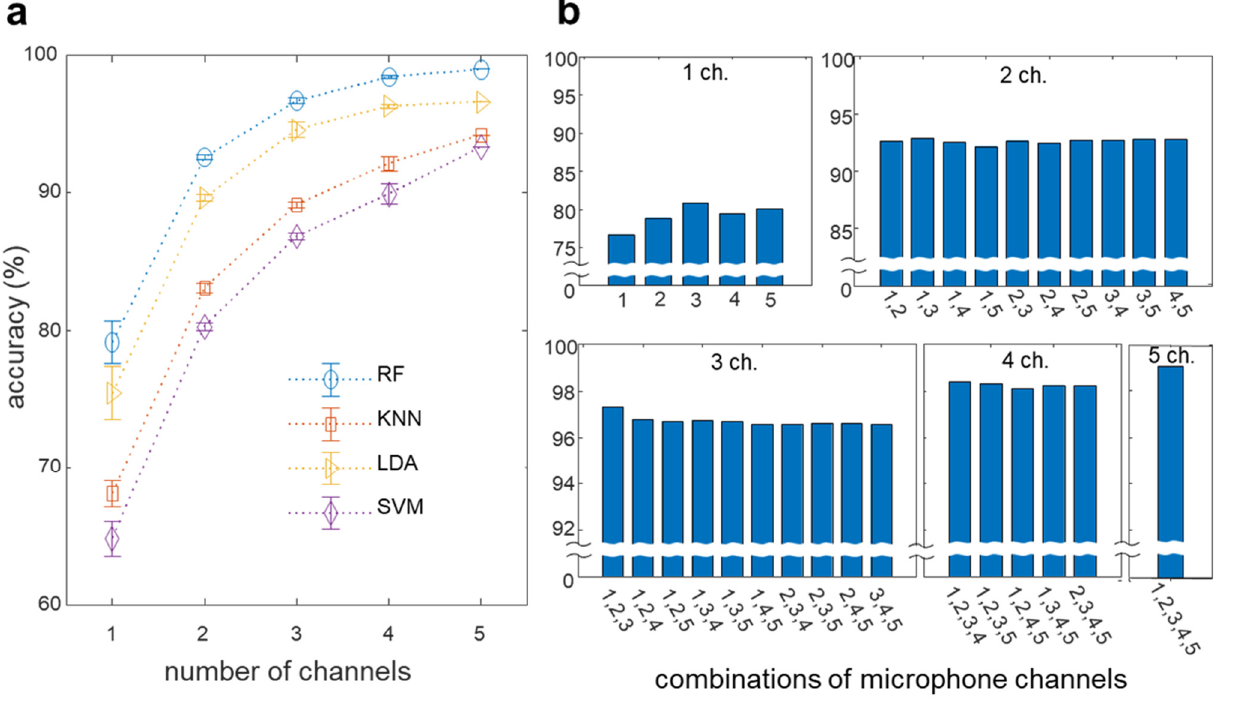
Figure 6. Identity recognition based on multichannel bioacoustics. ( a ) Comparison of identification accuracy for four models according to the number of channels. ( b ) Identification accuracy in the RF according to finger channel combination.